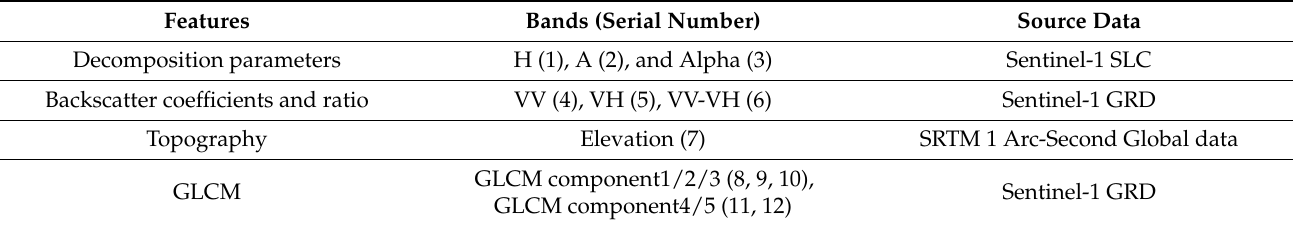
Table 1. Summary of features used for lithology